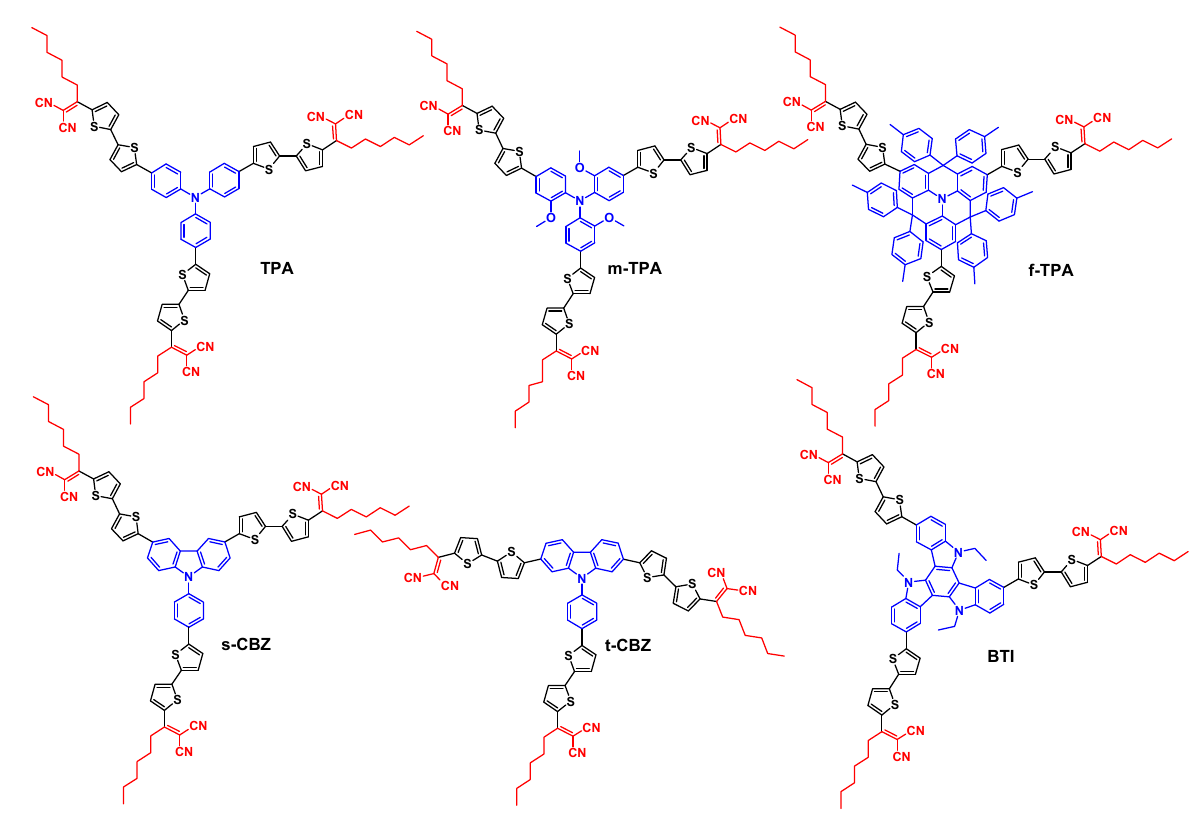
Figure 1. Chemical structures of the star-shaped donor-acceptor molecules: TPA , m-TPA , f-TPA , s-CBZ, t-CBZ and BTI .